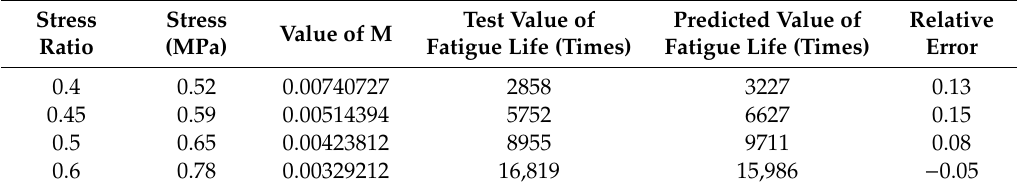
Table 4. Test and prediction results of fatigue life.